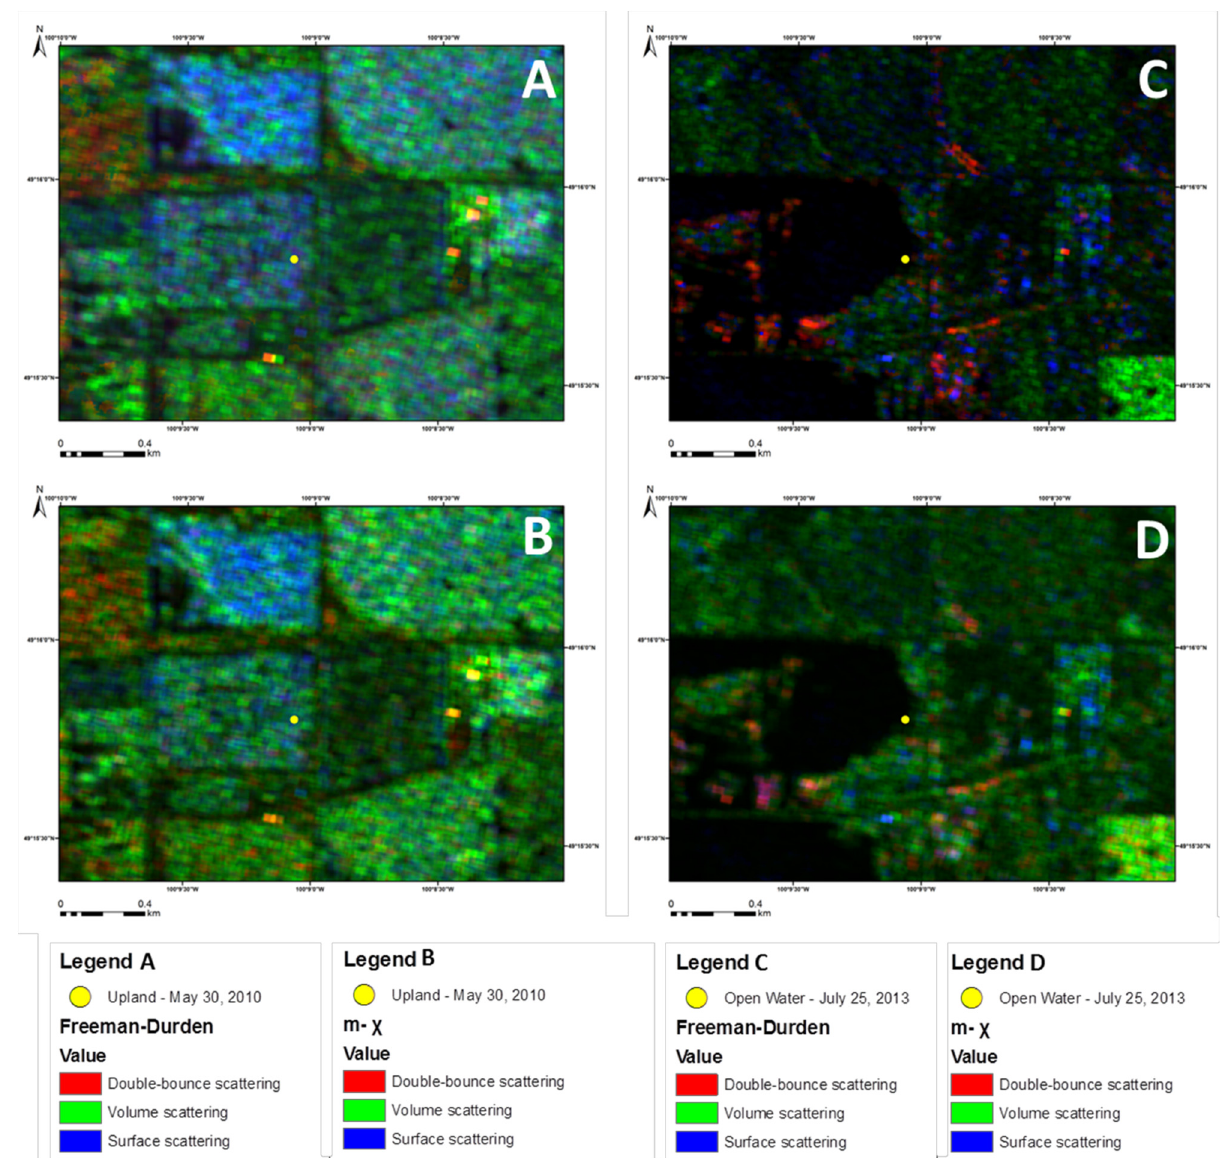
Figure 8. This image shows the transition from upland vegetated areas on 30 May 2010 ( A , B ), to open water on 25 July 2013 ( C , D ). Images (A) and (C) were produced from the Freeman-Durden decomposition and images (B) and (D) from the m- χ decomposition. Both decompositions were able to clearly map the change from upland vegetation to open water because the upland areas had a strong volume scattering response and the open water returned very little backscatter to the satellite and, thus, appeared